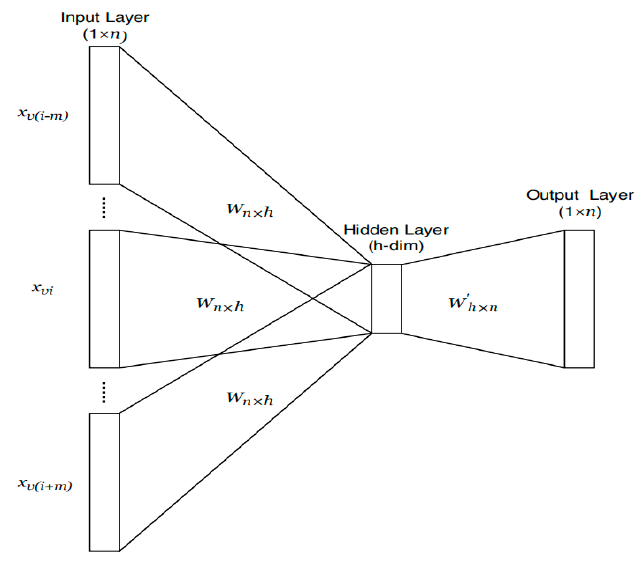
Figure 2. Continuous bag of words (CBOW) model [19].